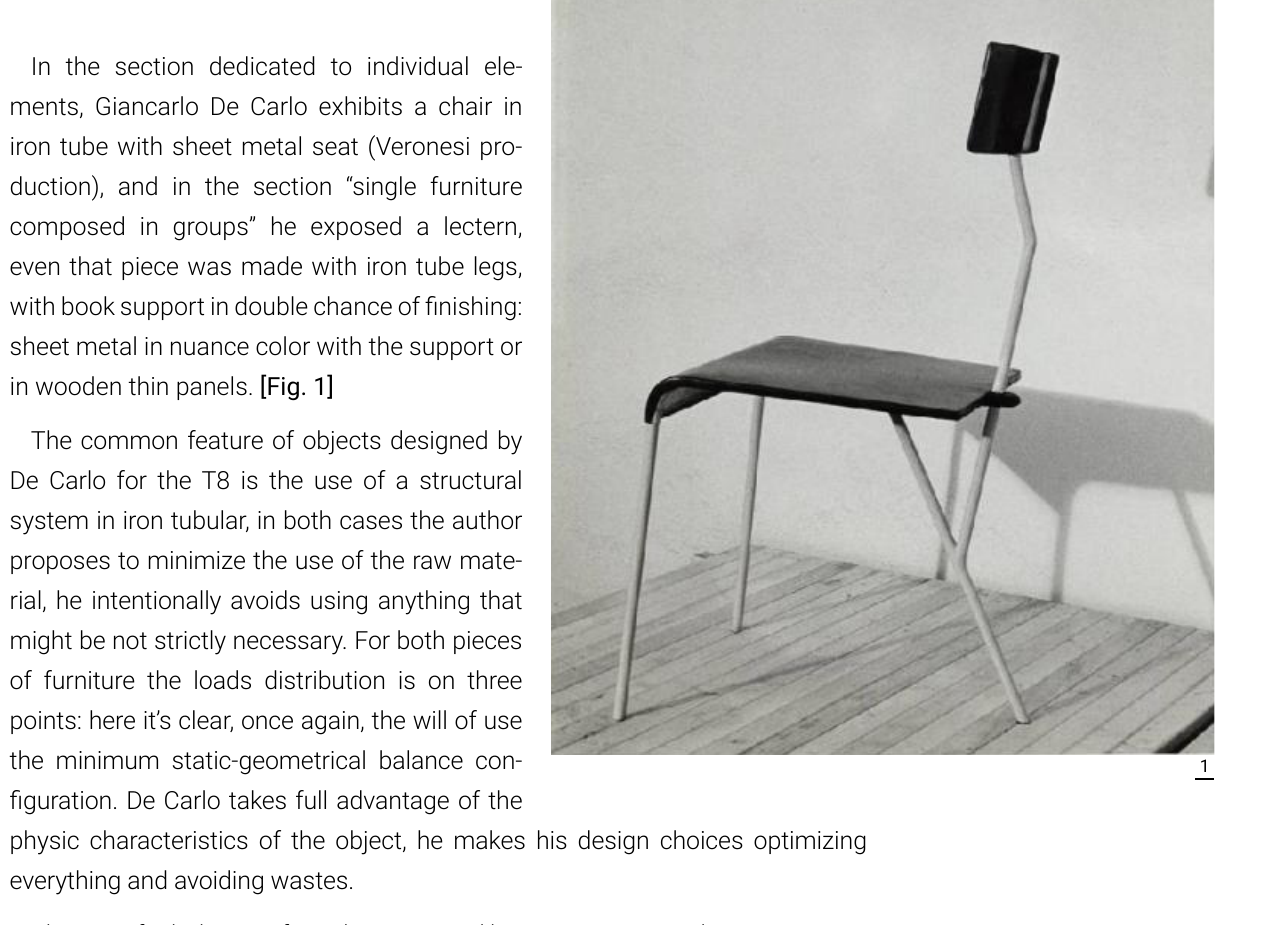
Fig. 1 Side view of the tubular and metal sheet designed by Giancarlo De Carlo (Veronesi production), exhibited in 8th Triennale furniture section, part one, single furniture divided by function. (ph. N.D.) source: http://www.lombardiabenic- ulturali.it/fotografie/schede/